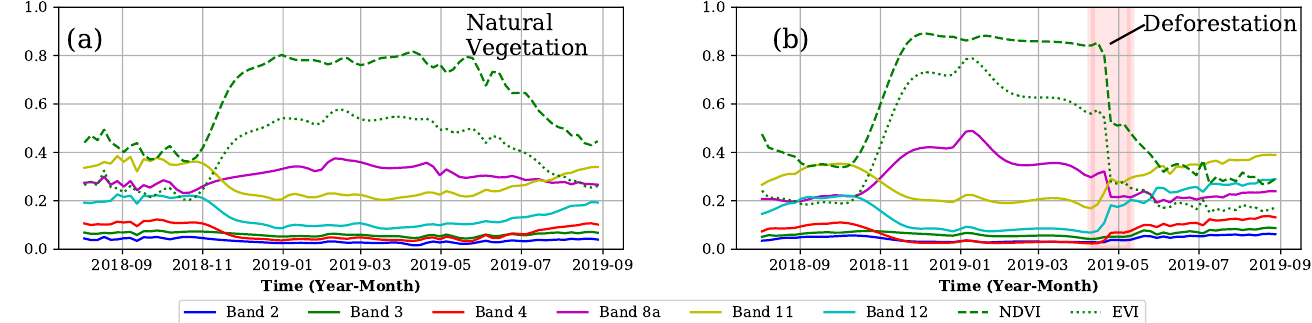
Figure 3. Examples of Sentinel LSTM training samples time series for ( a ) Natural Vegetation and ( b )